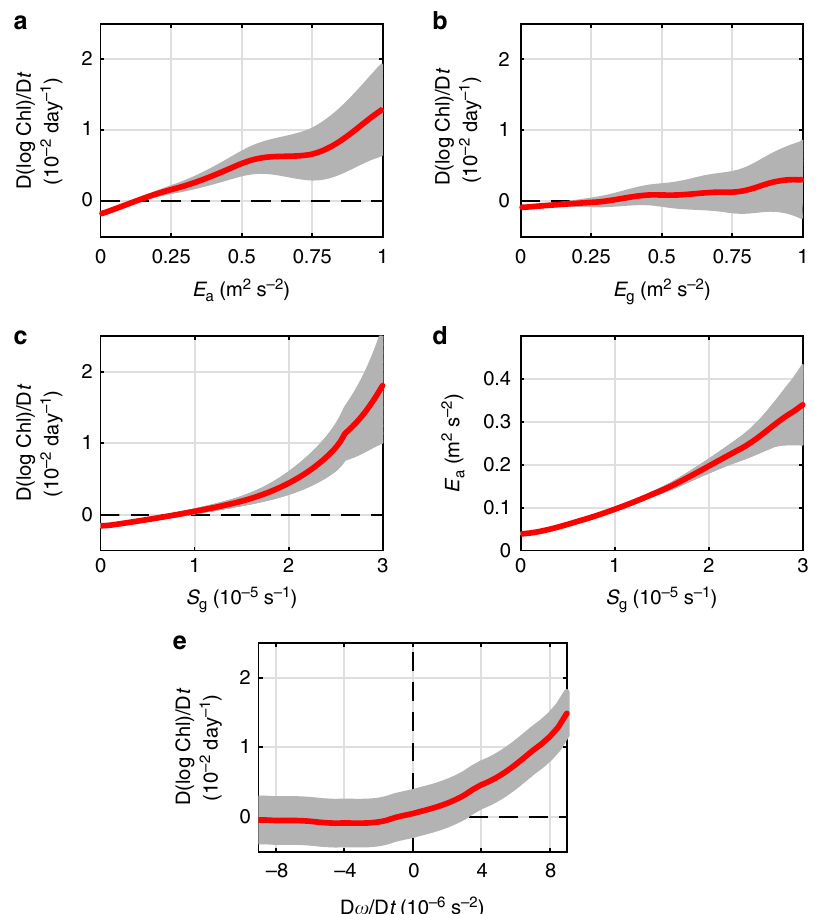
Fig. 2 Chlorophyll variation rate vs. kinetic energy and strain rate. Globally averaged curves of Lagrangian chlorophyll variation rate D(log Chl)/D t as a function of local a ageostrophic kinetic energy E a , b geostrophic kinetic energy E g , and c geostrophic strain rate S g . d Globally averaged curve of ageostrophic kinetic energy E a as a function of local geostrophic strain rate S g . e Globally averaged curves of Lagrangian chlorophyll variation rate D(log Chl)/D t as a function of the Lagrangian derivative of modi fi ed geostrophic vorticity D ω / D t . In a , b , D(log Chl)/D t is composited against E a and E g using a moving average window with a width 0.05 m 2 s − 2 . In c , d , E a and D(log Chl)/D t are composited against S g using a moving average window with a width 0.1 × 10 − 5 s − 2 . In e , D(log Chl)/D t are composited against the D ω /Dt using a moving average window with a width 0.5 × 10 − 6 s − 2 . The red curve in each sub fi gure represents the average curve and the light-gray shading represents the error bar computed by the standard error of average as Std/ N 1/2 , where Std and N are the standard deviation and data number within each averaging bin, respectively. Source data are provided as a Source Data fi